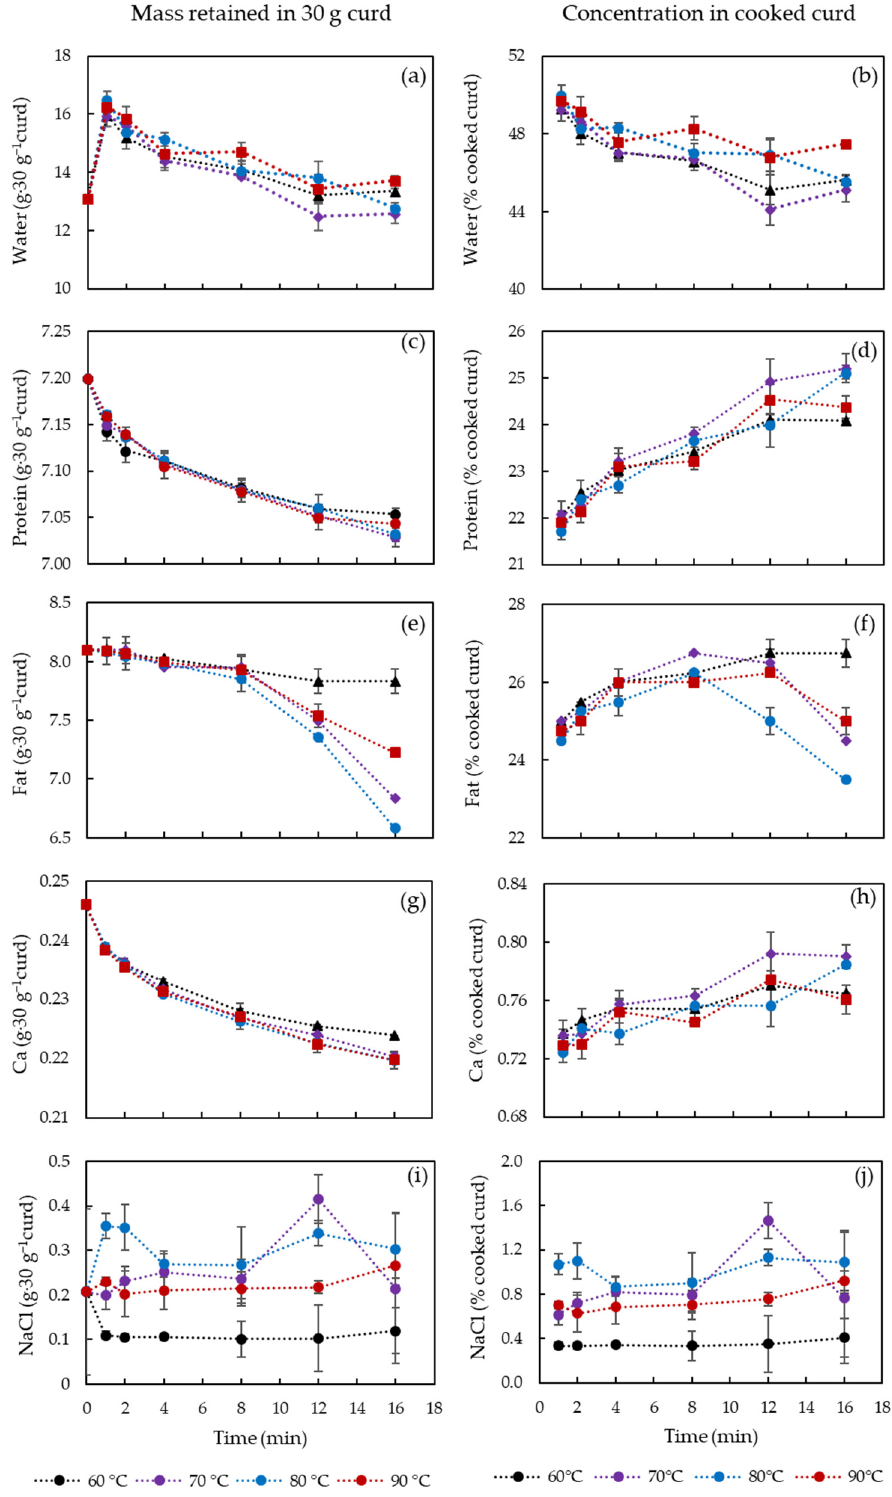
Figure 1. Content (%, w/w ) of water, protein, fat, calcium and NaCl retained in curd at varied cooking conditions. ( a , c , e , g , i ) show the content in 30 g original curd while ( b , d , f , h , j ) show the % concentration in final curd. The error bars indicate standard deviations.